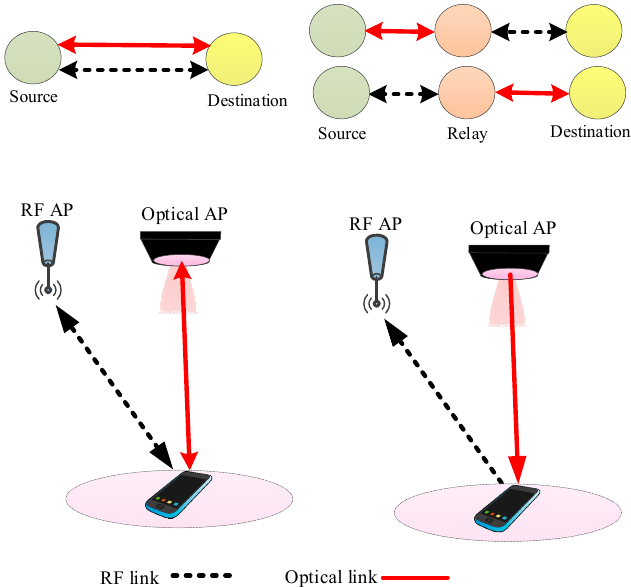
Figure 5. Few possible ways of connectivity using optical and RF hybrid systems.